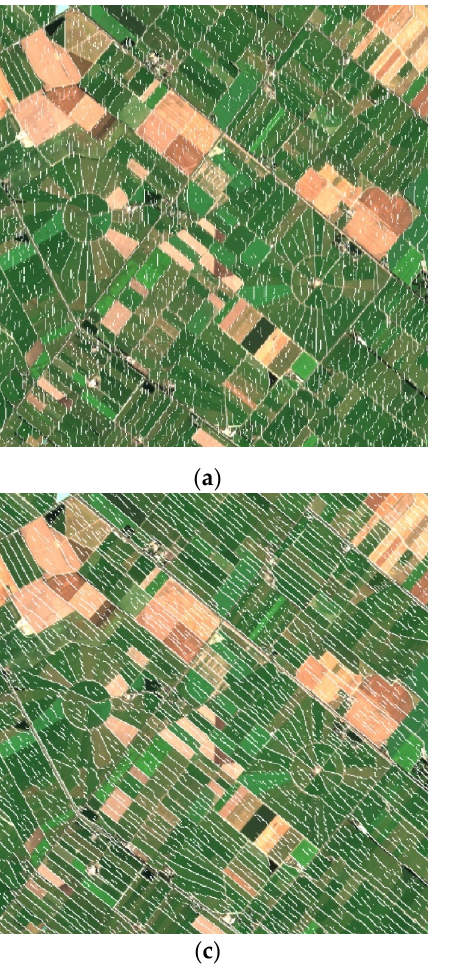
Figure 3. The output of three ( a – c ) different directional filters of the 16 required for the multitemporal field segmentation algorithm, and ( d ) the combined, trimmed output of the algorithm. In all cases, the linework is overlaid on pasture fields in Mid-Canterbury.